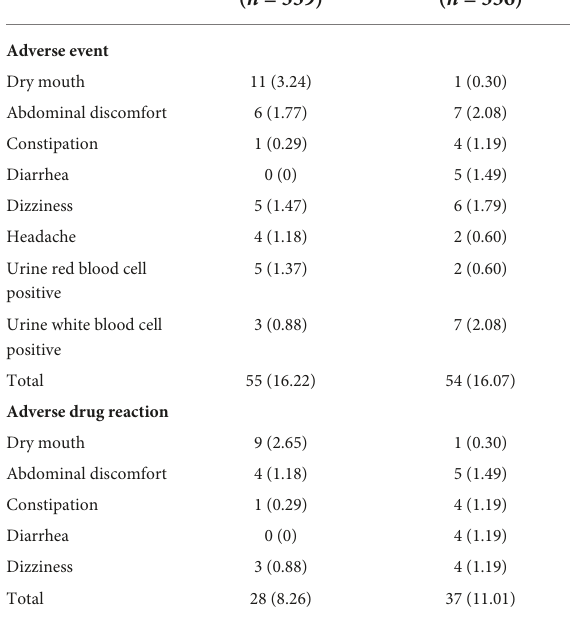
TABLE 5 Adverse events and adverse drug reactions occurring in > 1% of patients with generalized anxiety disorder who were treated